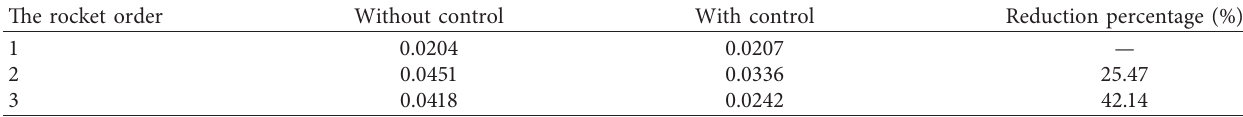
Table 3: Comparison of the maximum value of _ θ